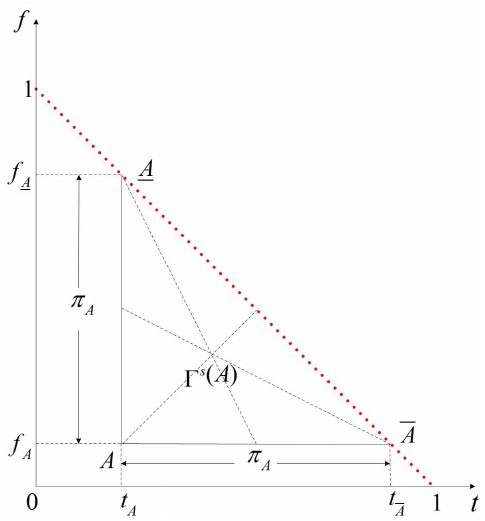
Figure 2. The simple centroid transformation of